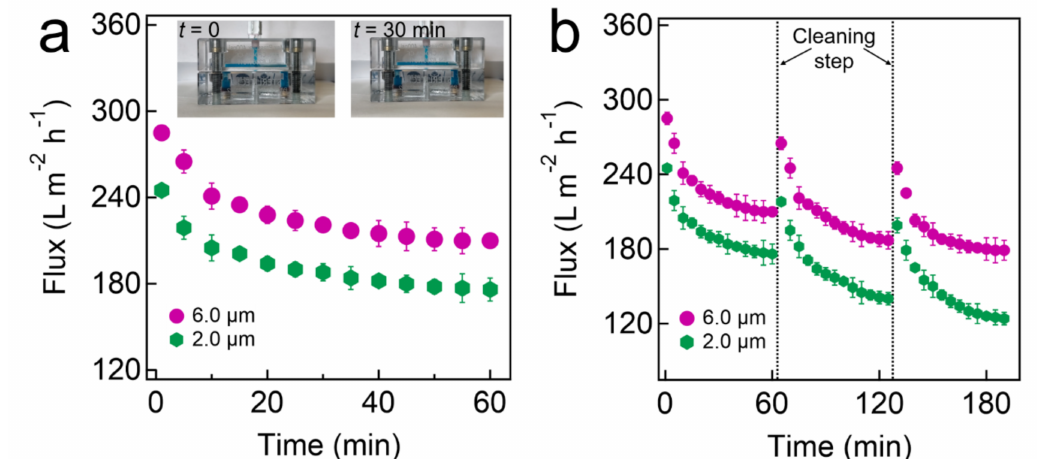
Figure 4. ( a ) Time-dependent flux measurements during the continuous separation of oil-water mixtures using prewetted filters with various inherent nominal pore sizes, which were coated with F-PEGDA (20 wt.%). The inset demonstrates the separation experiment using a cross-flow apparatus. ( b ) Time-dependent flux measurements during the continuous separation of oil-in-water emulsion with cleaning steps in